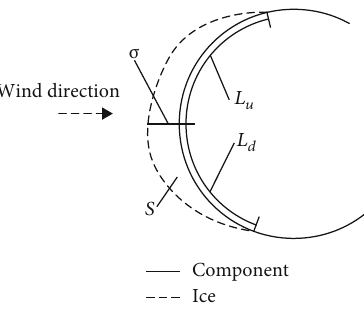
Figure 19: Typical characteristic